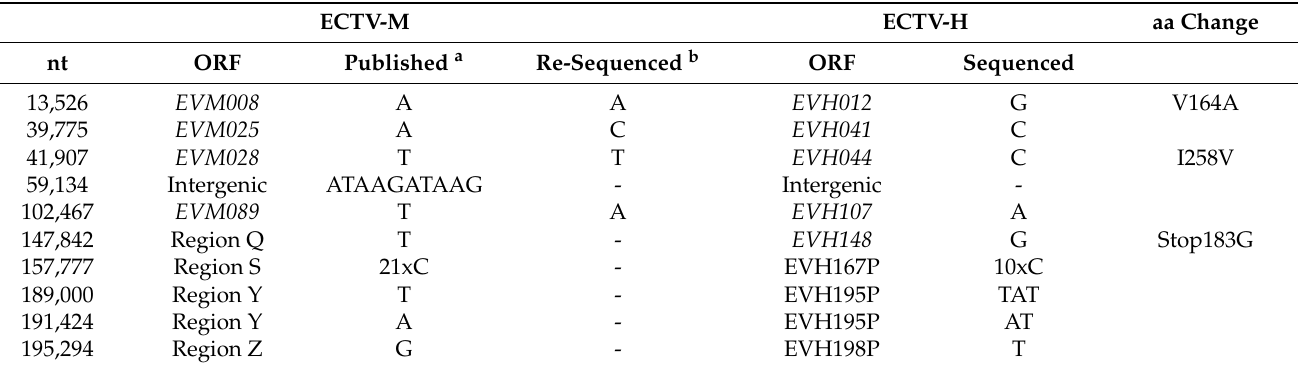
Table 5. Differences at the nt and aa level between the ECTV-M and ECTV-H genomes. ECTV-M ECTV-H aa